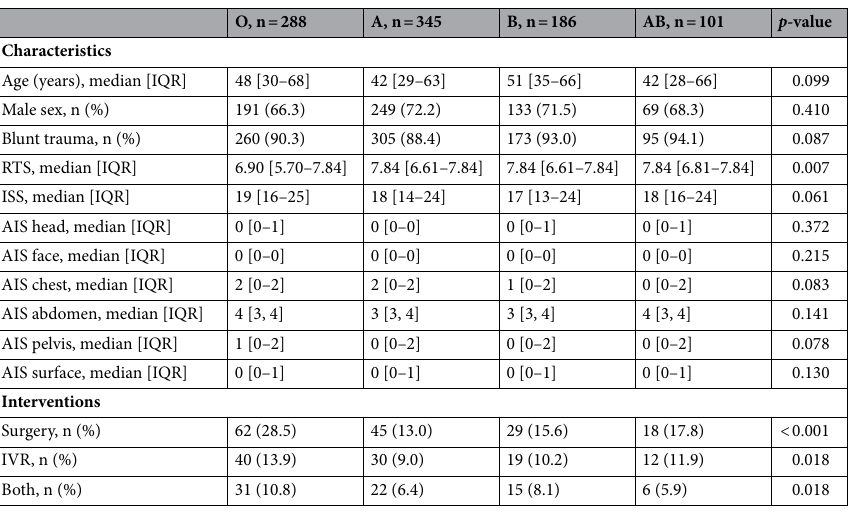
Table 1. Baseline characteristics of patients categorized according to blood type. Categorical variables are expressed as numbers (%), while continuous variables are presented as medians (25th–75th percentiles). AIS abbreviated injury scale, IQR interquartile range, RTS revised trauma score, ISS injury severity score, IVR interventional radiology.